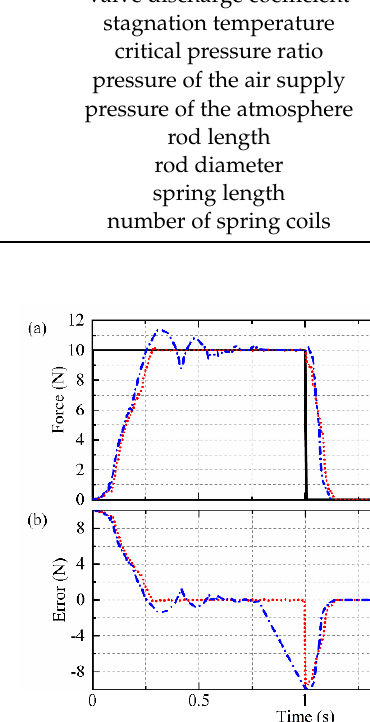
Figure 16. Tasks utilized on PC, cRIO-9074 RT, and cRIO-9074. personal computer (PC), Real-Time (RT), and field programmable gate array (FPGA).